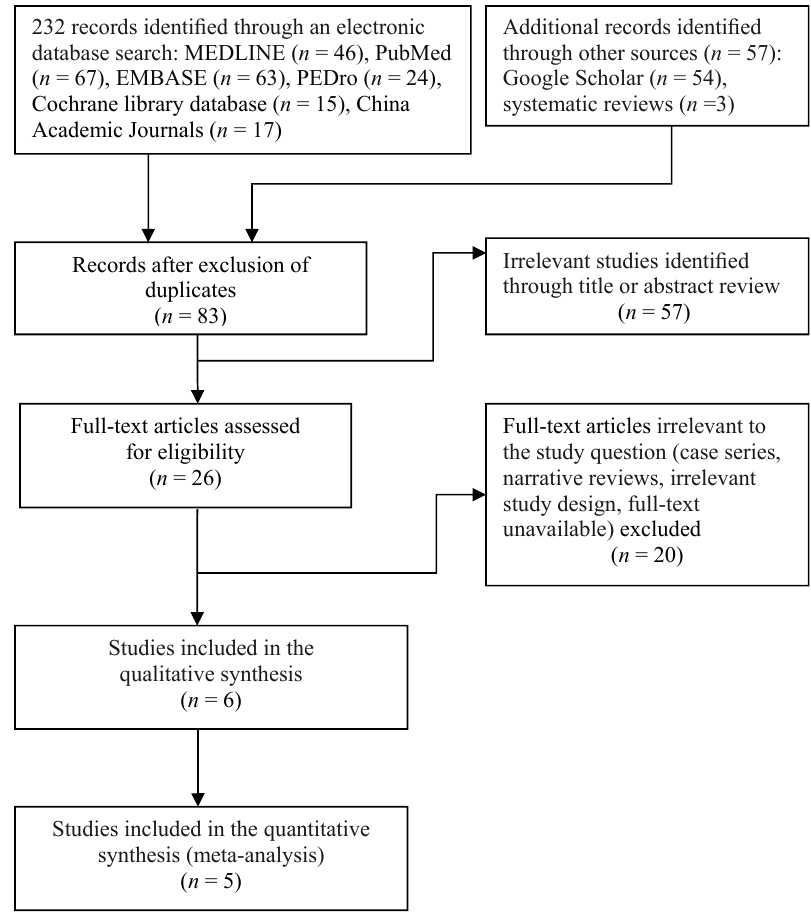
Figure 1. Flowchart of enrollment of the studies.